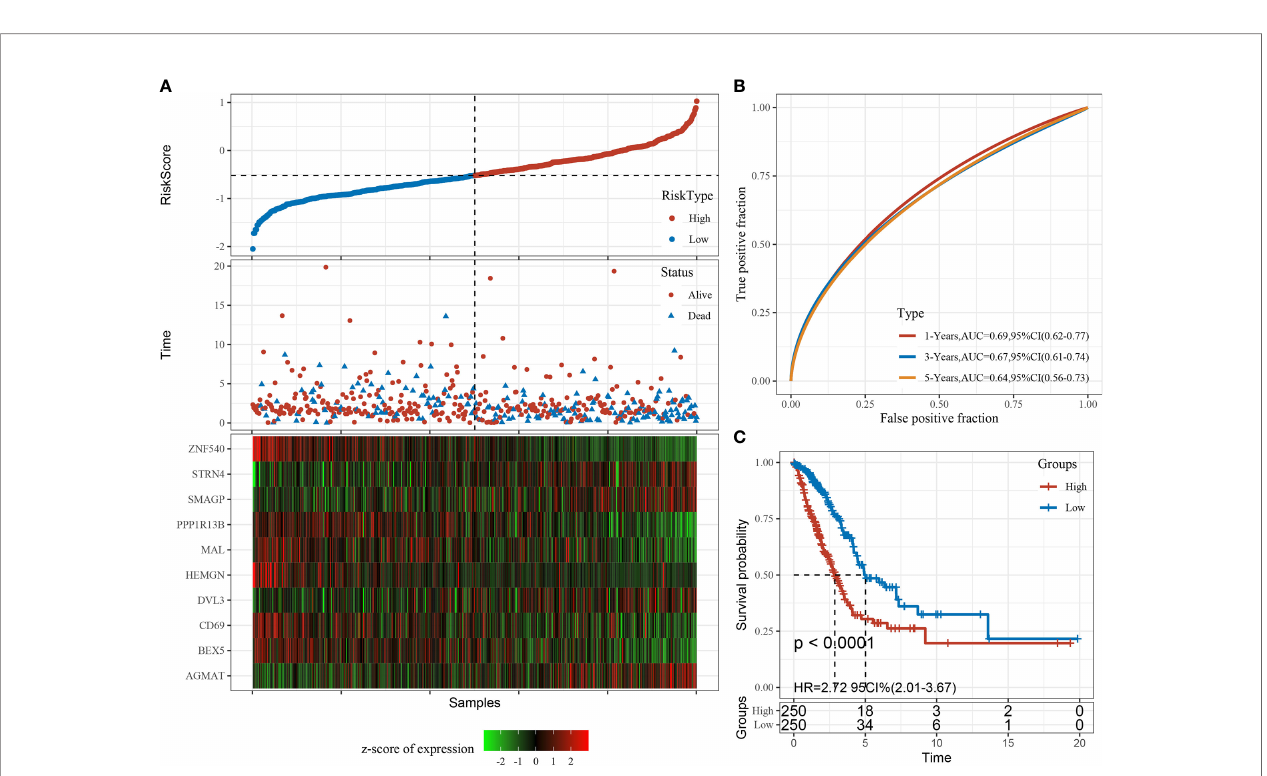
FIGURE 10 | Construction and evaluation of the prognostic risk model based on CD8 + T cell-associated genes using the training set. (A) RiskScore, time to live (TTL), and survival status after applying the 10-gene signature to the TCGA-LUAD training set. (B) Receiver operator curves and area under the curve based on the 10-gene signature. (C) Kaplan – Meier survival curves for high- and low-risk groups based on the 10-gene signature using the TCGA-LUAD training set.